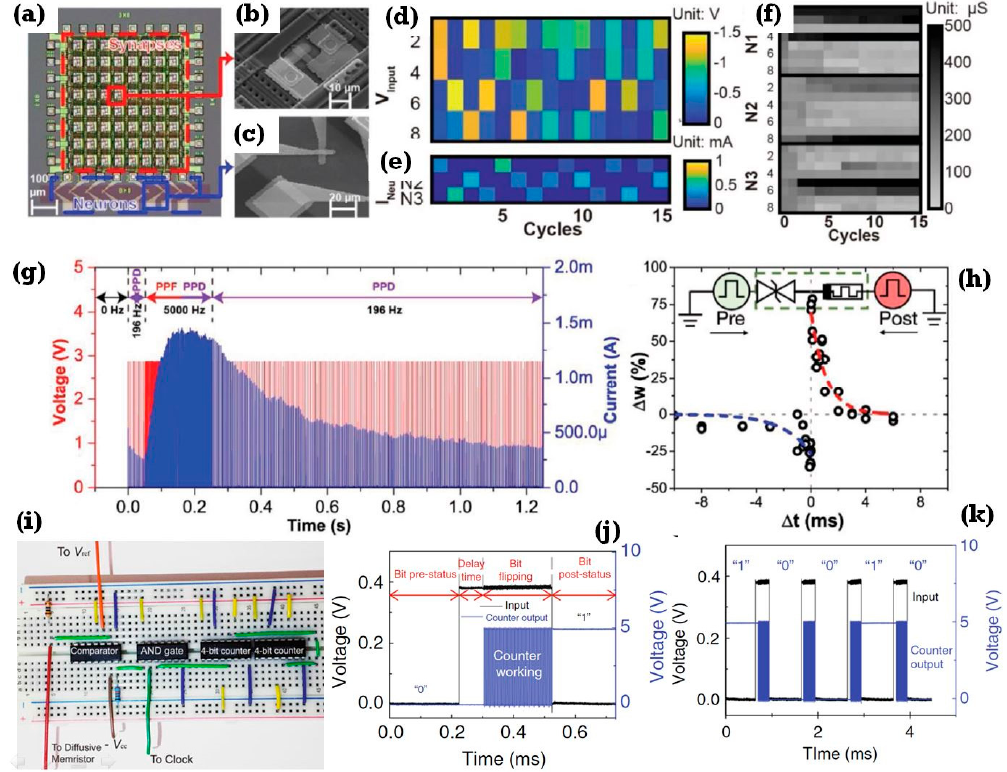
Figure 13. ( a ) The optical image of a typical 8 × 8 1T1R memristive neural network with the scanning electron microscope image of ( b ) a 1T1R device and ( c ) a single 1R device. ( d ) The input pattern, ( e ) peak neural current, and ( f ) synaptic weight at each training cycle. ( g ) The PP and ( h ) spike-time-dependent plasticity (STDP) measurements. ( i ) Image of circuital arrangement of a volatile diffusive memristor device for TRNG application with the ( j ) one counter output in response to 1 kHz input voltage pulse. ( k ) Random binary out flipping states over continuous switching cycles in the TRNG devices. (Reproduced from J. Appl. Phys. 2020, 127 (5), 051101, with the permission of AIP Publishing [127]).